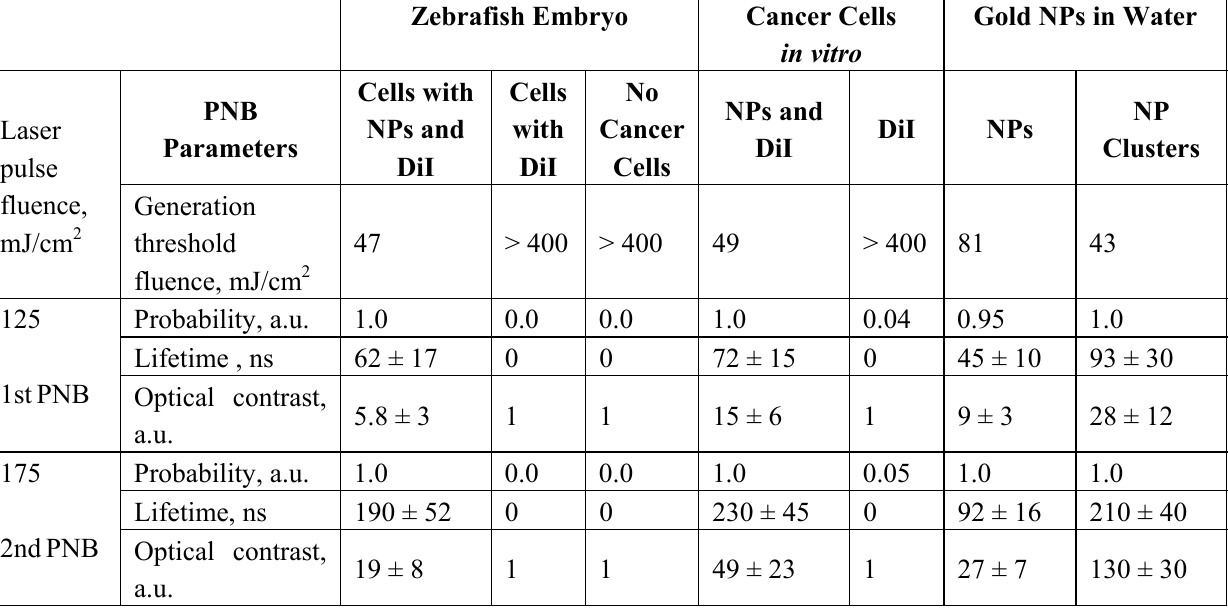
Table 4. Plasmonic nanobubble parameters in three studied systems [96] (a.u.: arbitrary units